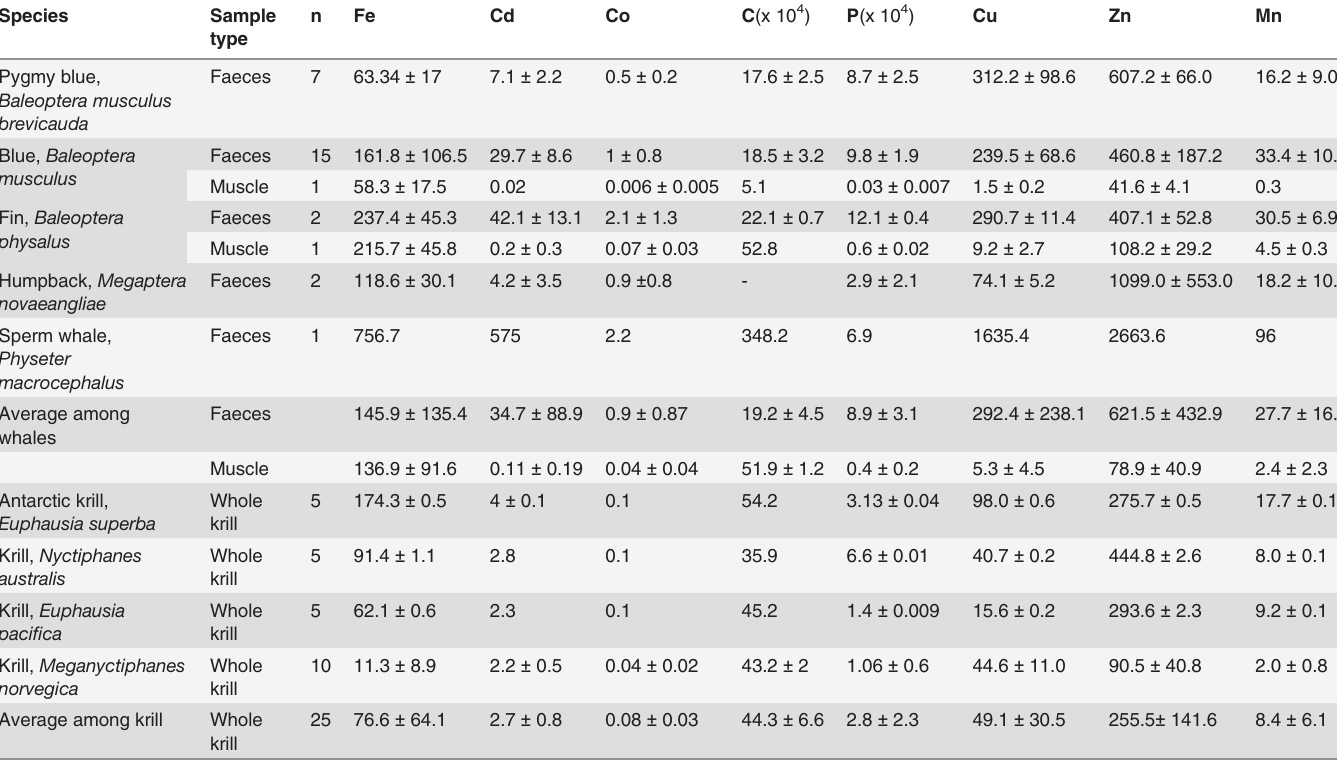
Table 2. Carbon, phosphate and trace element concentrations (mean ± standard deviation) in Antarctic krill and whales (mg kg -1 dry weight). Species